Question: According to the figure, is the described quantity increasing or decreasing?
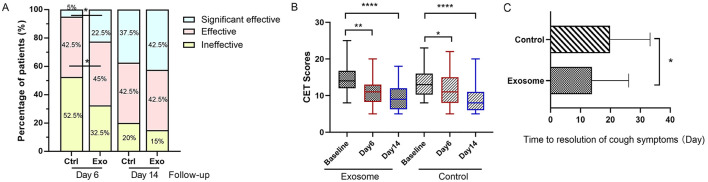
Answer: increasing